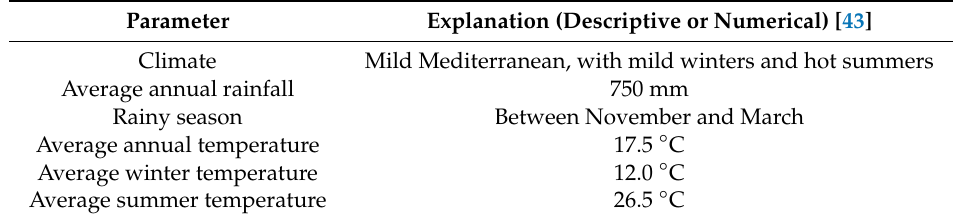
Table 1. Climatic data upon the homes